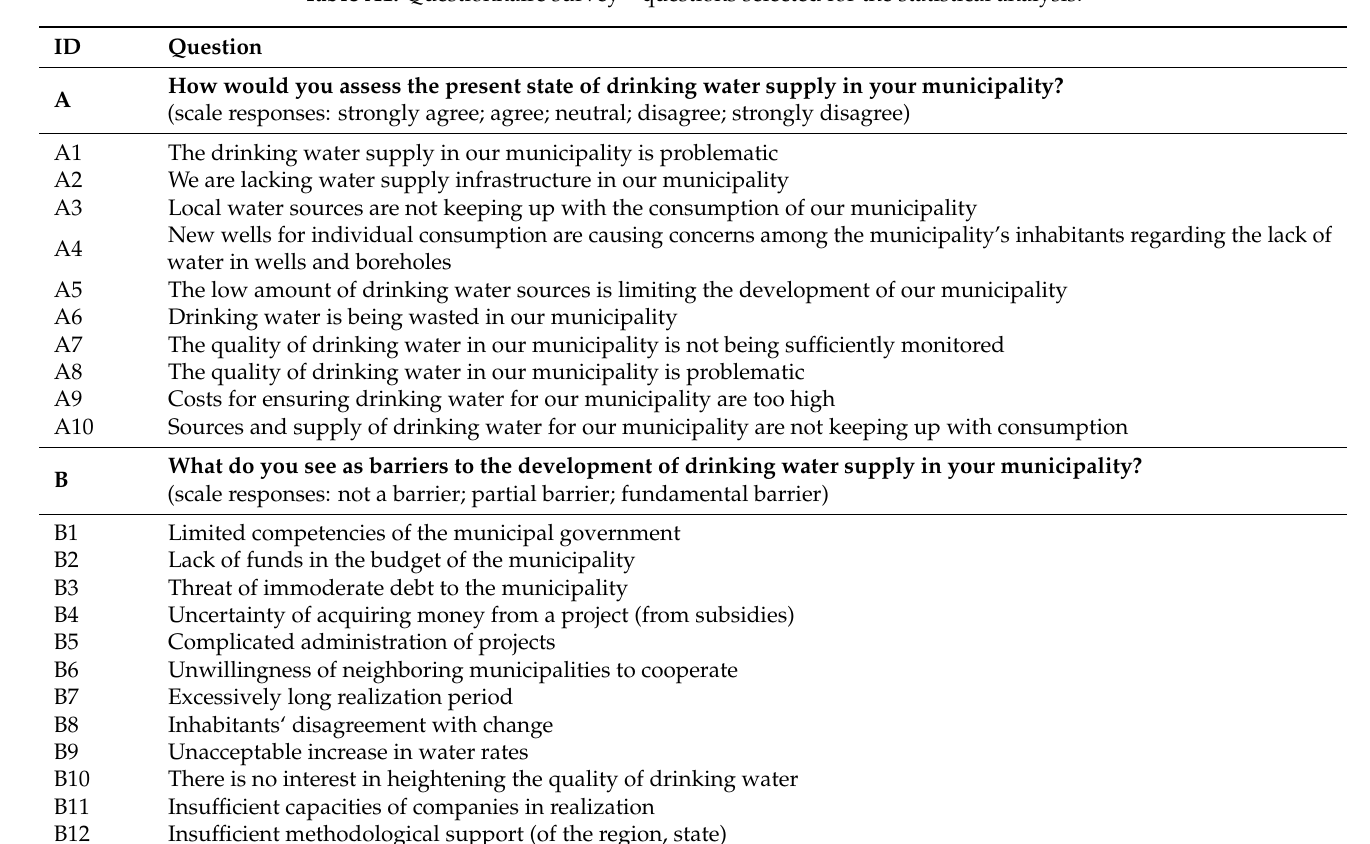
Table A1. Questionnaire survey—questions selected for the statistical